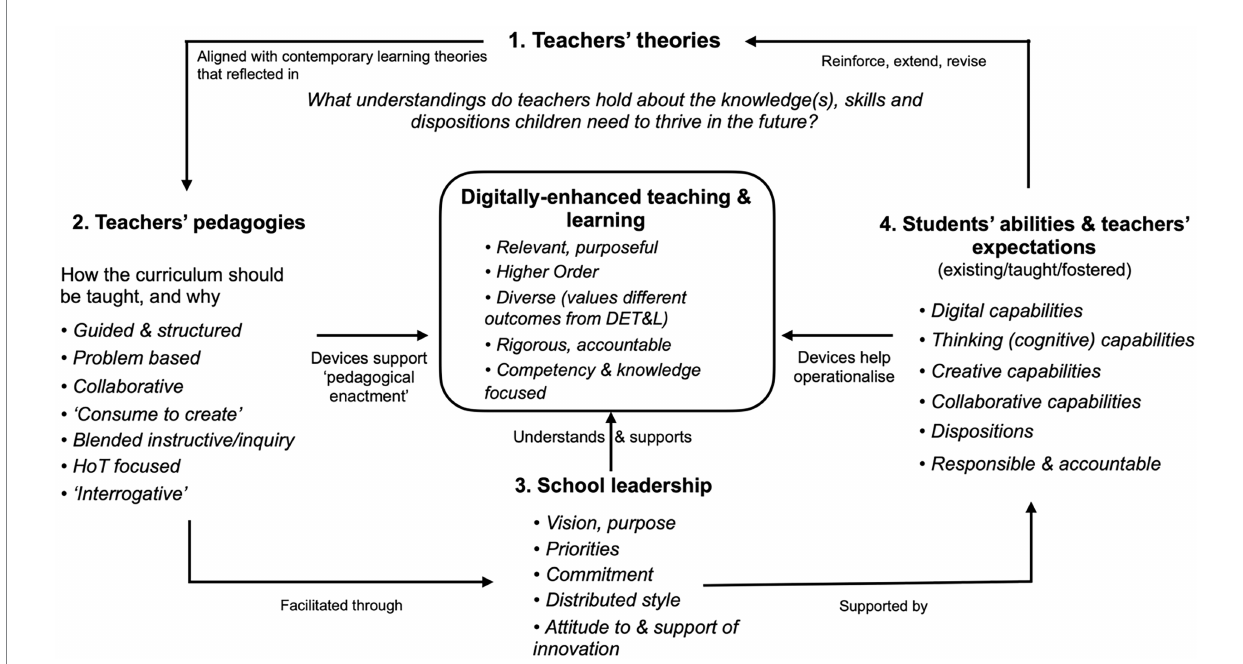
FIGURE 6 The relationship between four key elements underpinning effective mobile device use in these